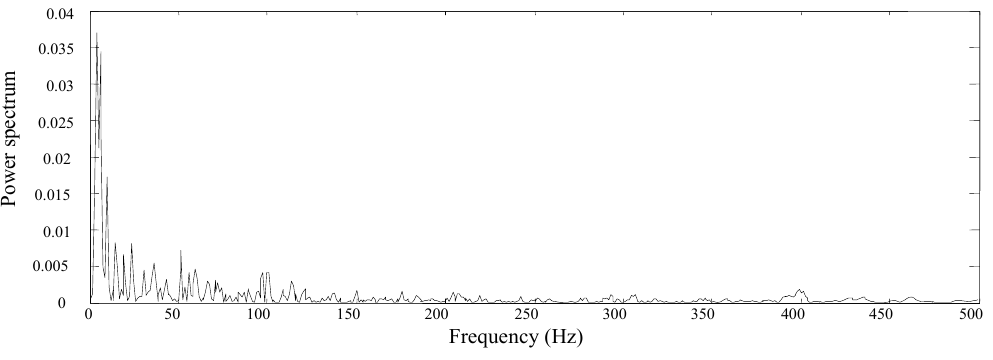
Fig. 10. Seismic acceleration power spectrum (site = type III).